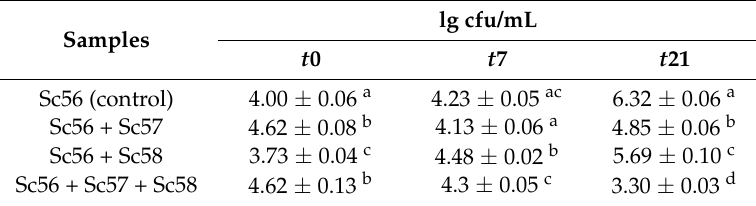
Table 5. B. bruxellensis Unifg 8 cell count (cfu/mL) on Wallerstein Laboratory Nutrient (WLN) agar medium from grape musts inoculated with different combinations of S. cerevisiae strains during AF: t 0, day of inoculation; t 7, 7 days from the inoculation; t 21, 21 days from the inoculation. Results of the ANOVA analysis are shown as letters on the data corresponding to the B. bruxellensis cell count: different letters on the same column indicate significant differences of 95%.